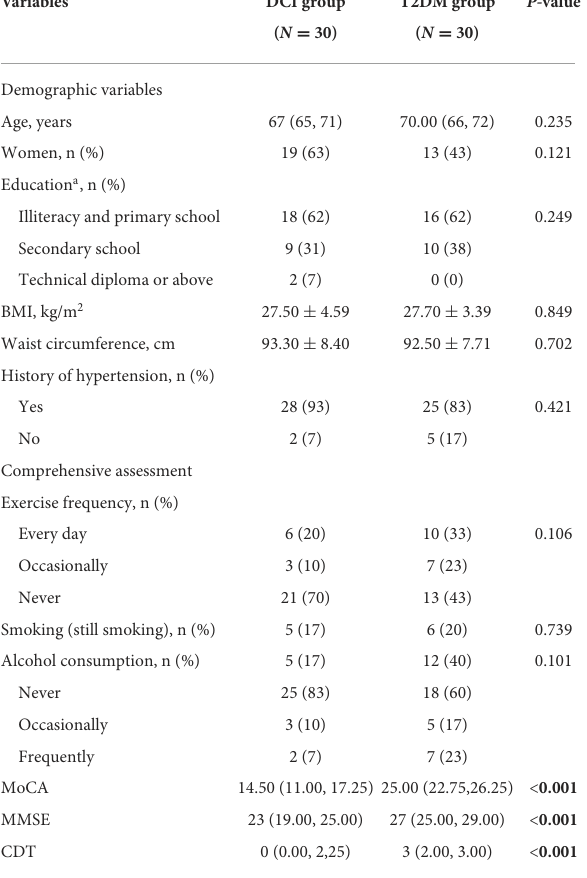
TABLE 2 The hematological parameters of DCI and T2DM